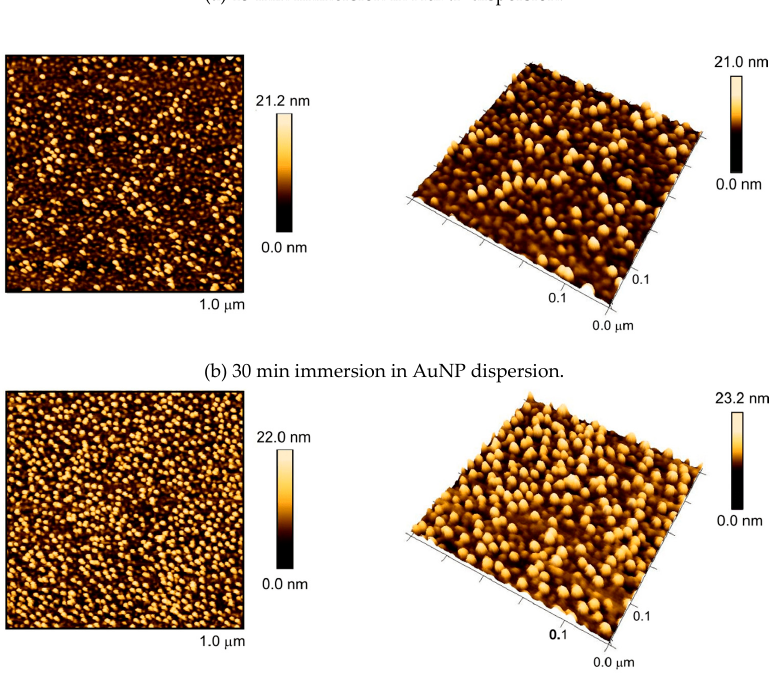
Figure 5. AFM images in 2D view ( left ) and 3D view ( right ) of preformed polystyrene nanostructures from the dewetting of grafted RAFT polystyrene with of M n = 64 kg / mol on gold surfaces after di ff erent incubation times with an aqueous sol of 13 nm AuNPs.